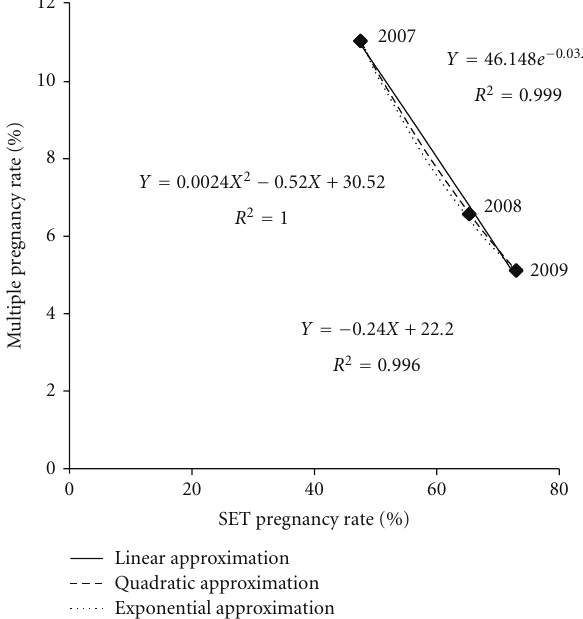
Figure 2: The multiple pregnancy rate plotted against SET pregnancy rate from 2007 to 2009 with linear and quadratic